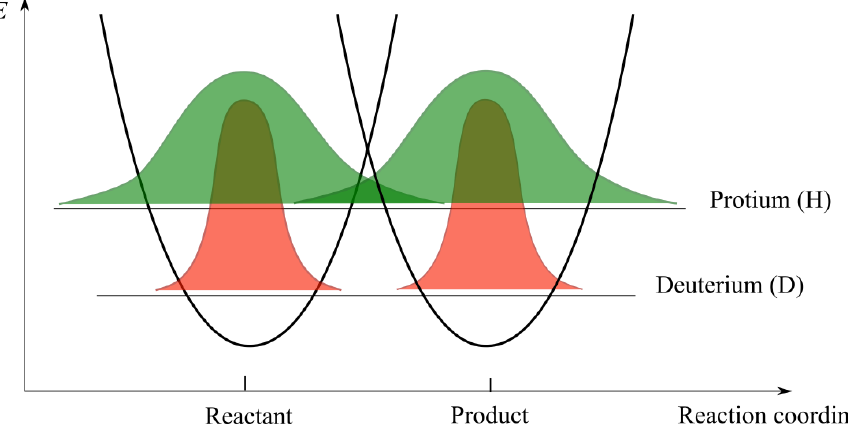
Figure 1. Illustration of the ground-state quantum mechanical tunnelling of hydrogen. Black parabolas represent potential energy ( E ) curves for reactant and product. The wavefunction of lighter isotope (protium, in green) is less localized due to a smaller mass in comparison to heavier isotope (deuterium, in red). Overlap of reactant’s and product’s hydrogen wavefunctions can lead to H-tunnelling. Tunnelling is very sensitive to the shape (width and height) of the barrier; it can happen